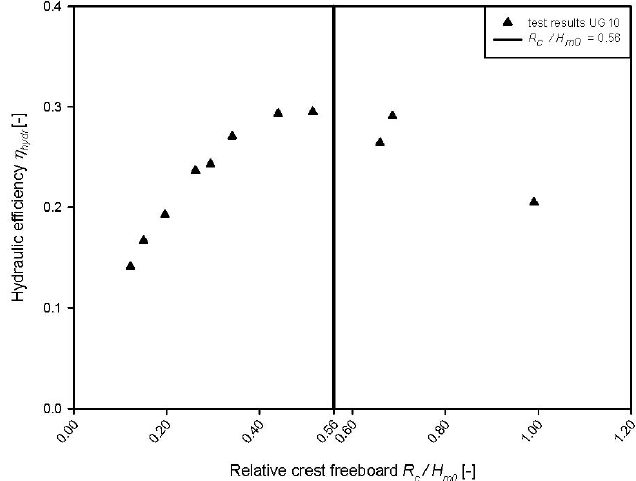
Figure 1. Graph of hydraulic efficiency as a function of the relative crest freeboard, for test results of the UG10 dataset with cot 1.4 α =